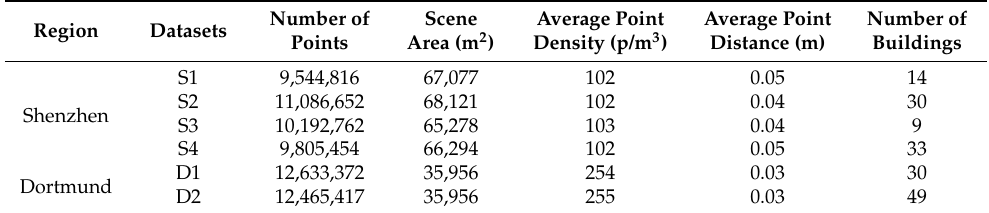
Table 1. Detailed information of the oblique images.